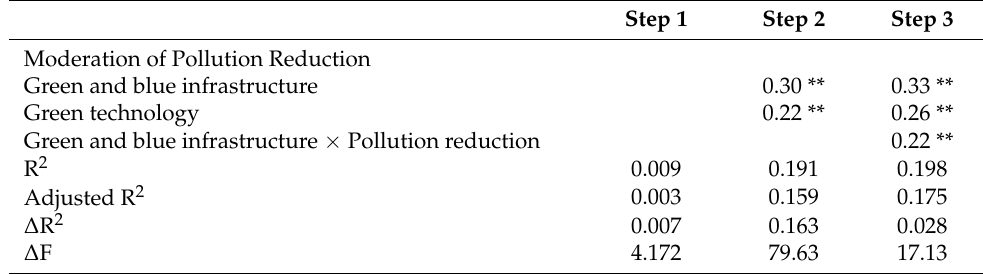
Table 5. Outcomes of moderation analyses using hierarchical